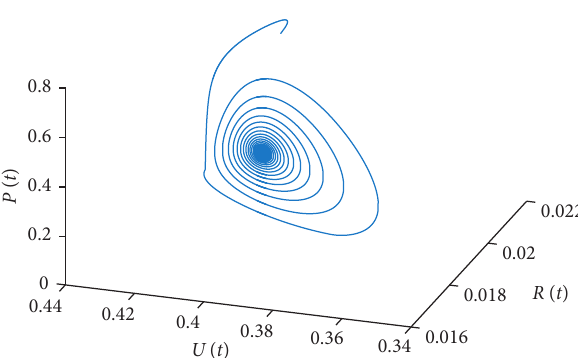
Figure 8: Portrait diagram of land model (30) with ϕ � 0 . 90, � 728 . 403. τ � 700 < τ 0